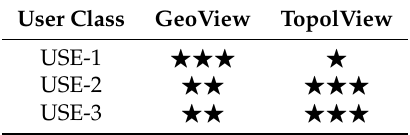
Table 2. Degree of requirement of multi-class